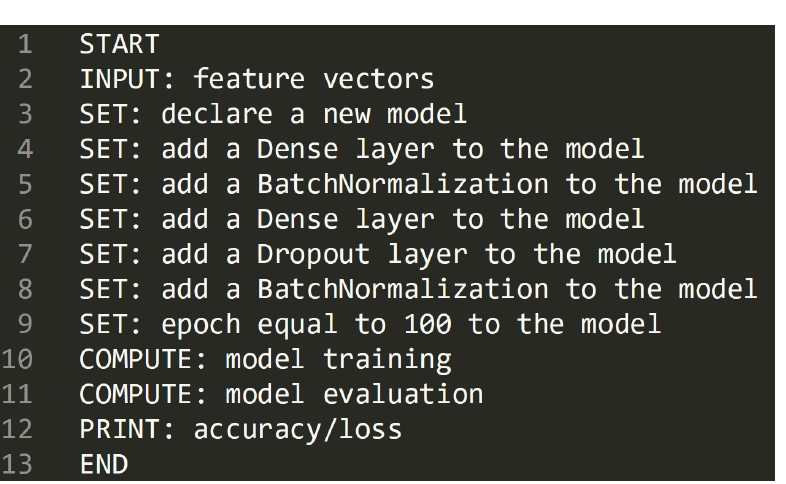
Figure 7. Pseudocode for the proposed neural